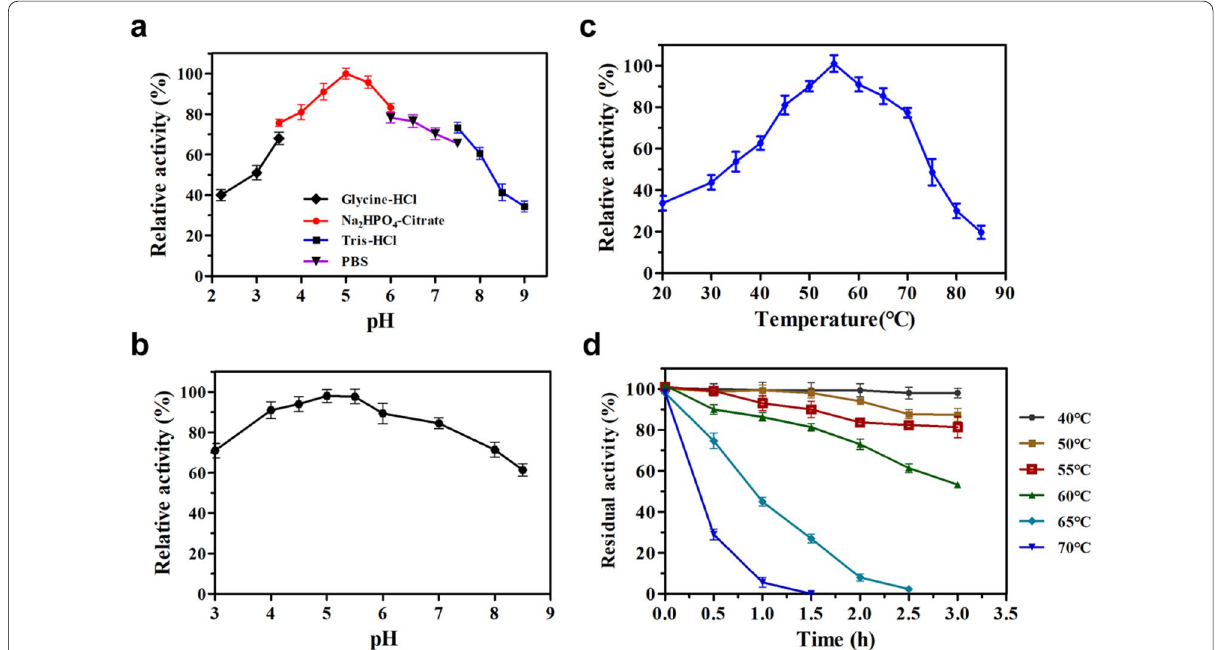
Fig. 3 Effects of pH and temperature on the activity of PcMan113. a pH dependence of PcMan113. Activity was measured in the reaction mixtures adjusted to various pH values with glycine–HCl buffer, Na 2 HPO 4 –citrate buffer, PBS buffer and Tris–HCl buffer. b Analysis of pH stability of PcMan113. PcMan113 was preincubated at different pH values for 1 h at room temperature, and the residual activity was determined at various pH conditions. c Temperature dependence of PcMan113. Activity was measured at various temperatures in the standard assay conditions. d Thermostability analysis of PcMan113. PcMan113 was preincubated at various temperatures for 30 min. The activities of wild‑type PcMan113 are represented as 100 in optimal reaction conditions, error bars are standard deviations ( n 3) =